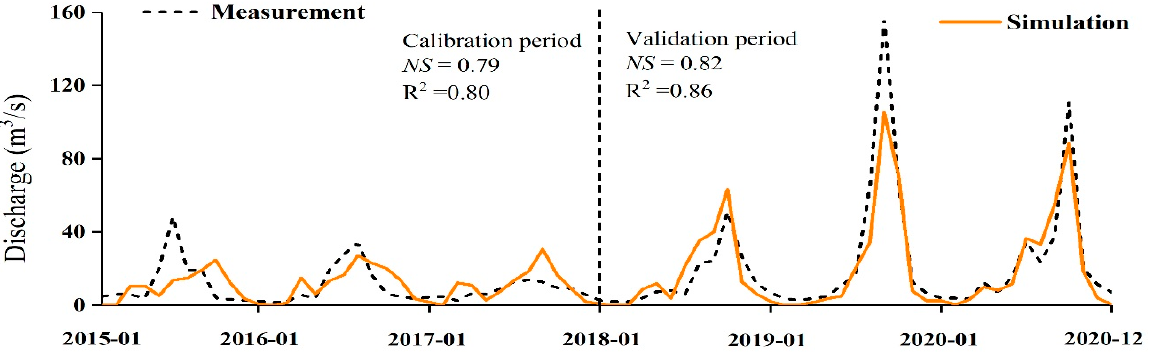
Figure 7. Comparison of runoff rate determination and validation.